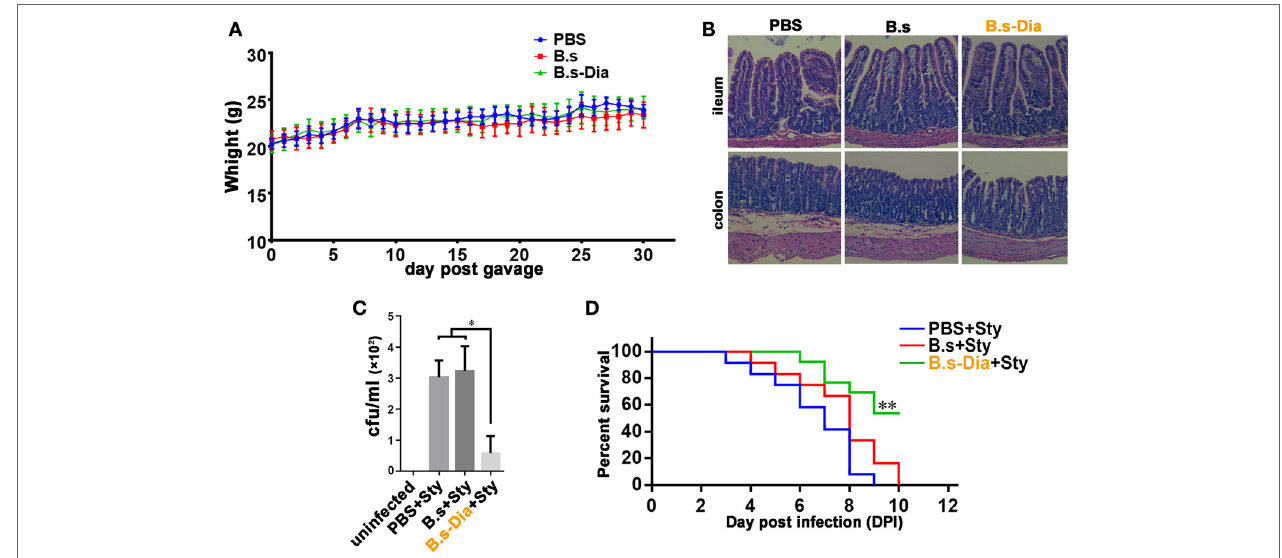
FigUre 2 | intragastric administration of 4,4 ′ -diaponeurosporene-producing Bacillus subtilis (B.s-Dia) improved the survival of mice upon Salmonella typhimurium infection . (a) Mice were intragastrically given 1 × 10 9 colony forming units (cfu) B.s or B.s-Dia every day for 1 month, and the body weight was measured. (B) On day 30, mice were sacrificed, and the ileum and colon were removed, and paraffin sections were made and followed by hematoxylin and eosin staining. (c,D) Mice were given PBS or 1 × 10 9 cfu B.s or B.s-Dia every day by gavage for 7 days. On day 8, all mice were intragastrically infected with 5 × 10 8 cfu S. typhimurium (Sty). After 12 h, the number of S. typhimurium in mice mesenteric lymph nodes was counted by Luria–Bertani (LB) ager plate containing 500 µg/ml streptomycin (c) . Mouse survival rate was recorded daily for 10 days (D) . Survival curves were analyzed using a Kaplan–Meier survival analysis with log-rank tests. One representative of three similar independent experiments is shown ( n = 12, ** P <